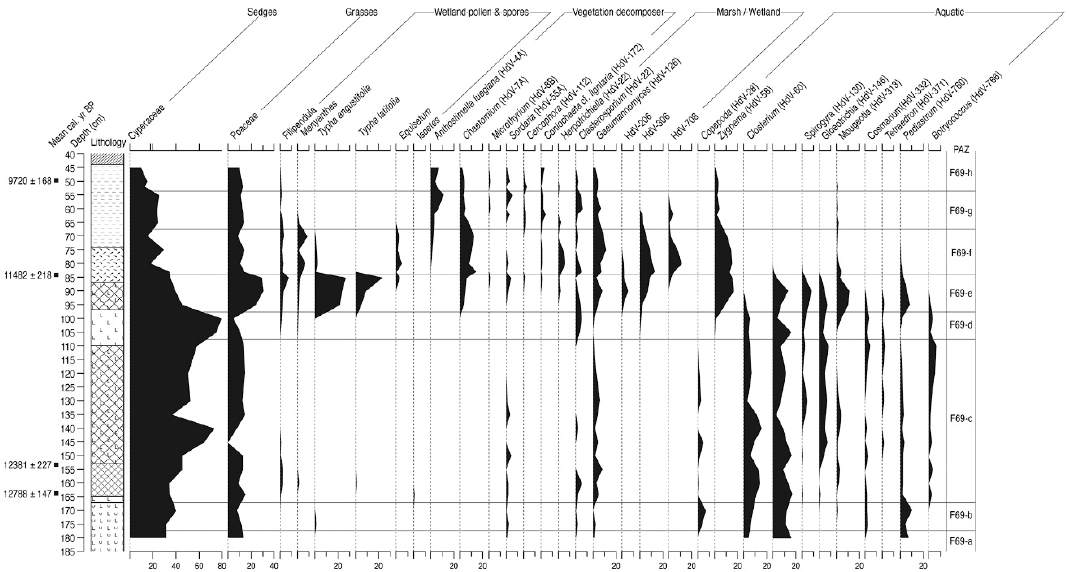
Figure 7. Wetland taxa and non-pollen palynomorph (NPP) diagram from Nosterfield, the Flasks 69. Frequencies are calculated as percentages of total land pollen. For lithology [57], see Table 3.